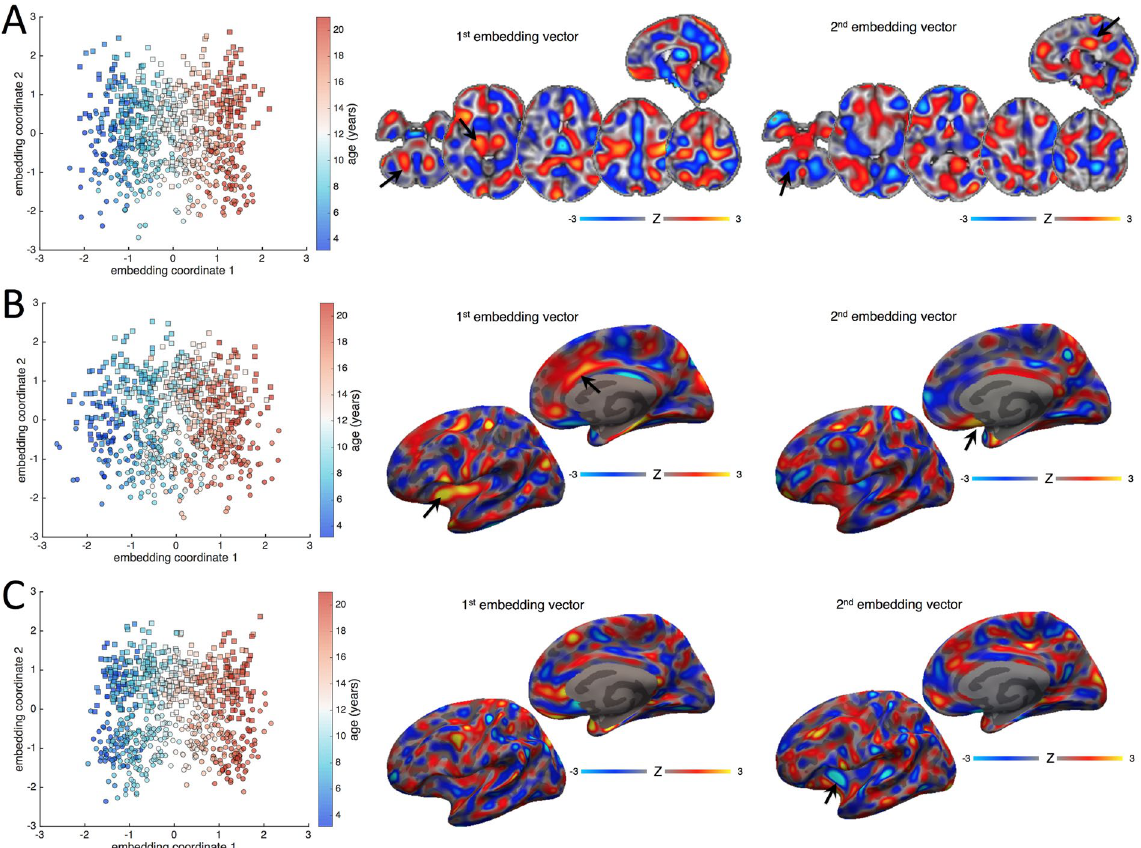
Figure 2. Manifold structure for tissue volume, cortical area and cortical thickness. Manifold structure is visualised for tissue volume ( A ), cortical area ( B ) and cortical thickness ( C ). For each image metric, the first two embedding coordinates are plotted against each other. Each point represents a subject; the colourbar indicates age and markers denote sex (square: male; circle: female). Images show the embedding vectors for the first and second coordinates, i.e.: the model coefficients in each voxel required to transform data into the embedded subspace. Maps are Z-scored for comparison